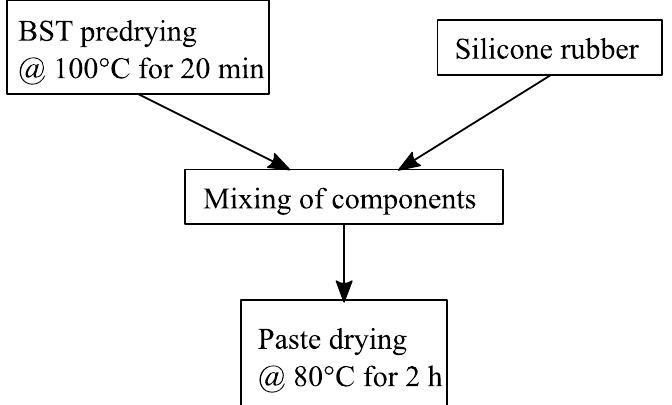
Figure 2. Flowchart of the dielectric paste processing. The BST powder was pre ‐ dried at 100 °C for 20 min. After that, it was thoroughly mixed with the silicone rubber, resulting in a paste with smooth consistency. The resulting paste was then dried again for 2 h at 80 °C or until it was dry.